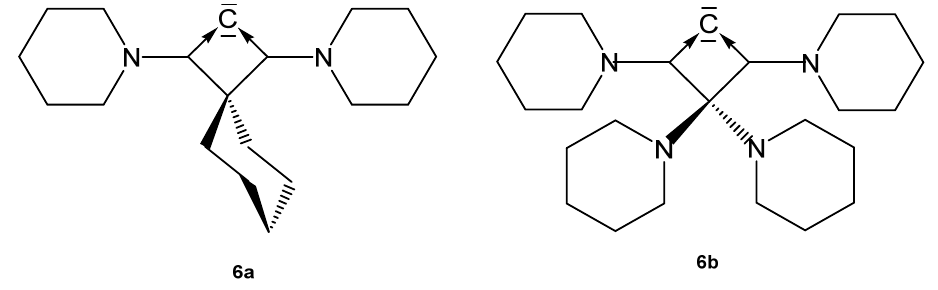
Figure 8. Structures of compounds 6a and 6b .